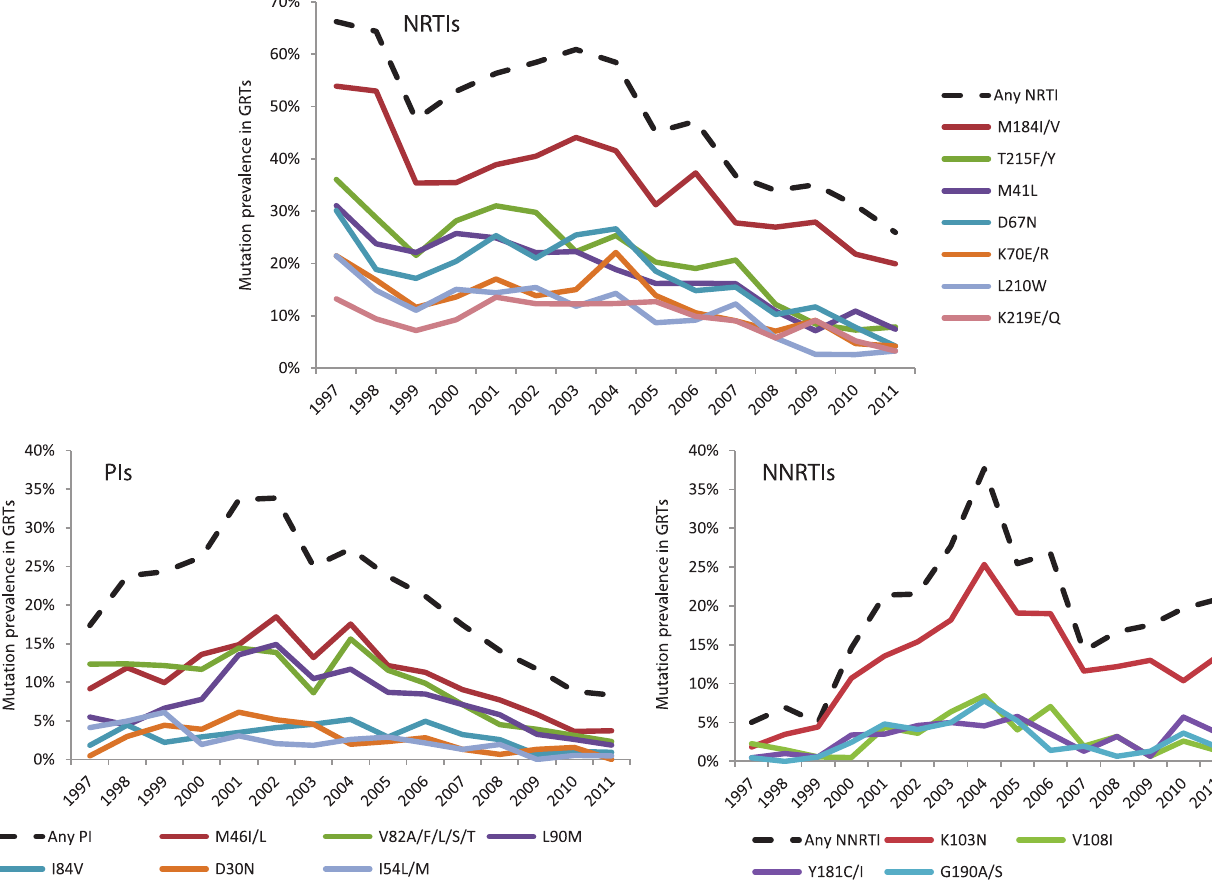
Figure 5. Prevalence trends of individual resistance mutations 1997–2011. Prevalence of the most common resistance mutations in relation to all performed GRTs per calendar year. All NRTI, PI and NNRTI associated mutations with a prevalence of at least 5% of GRTs any year have been included.